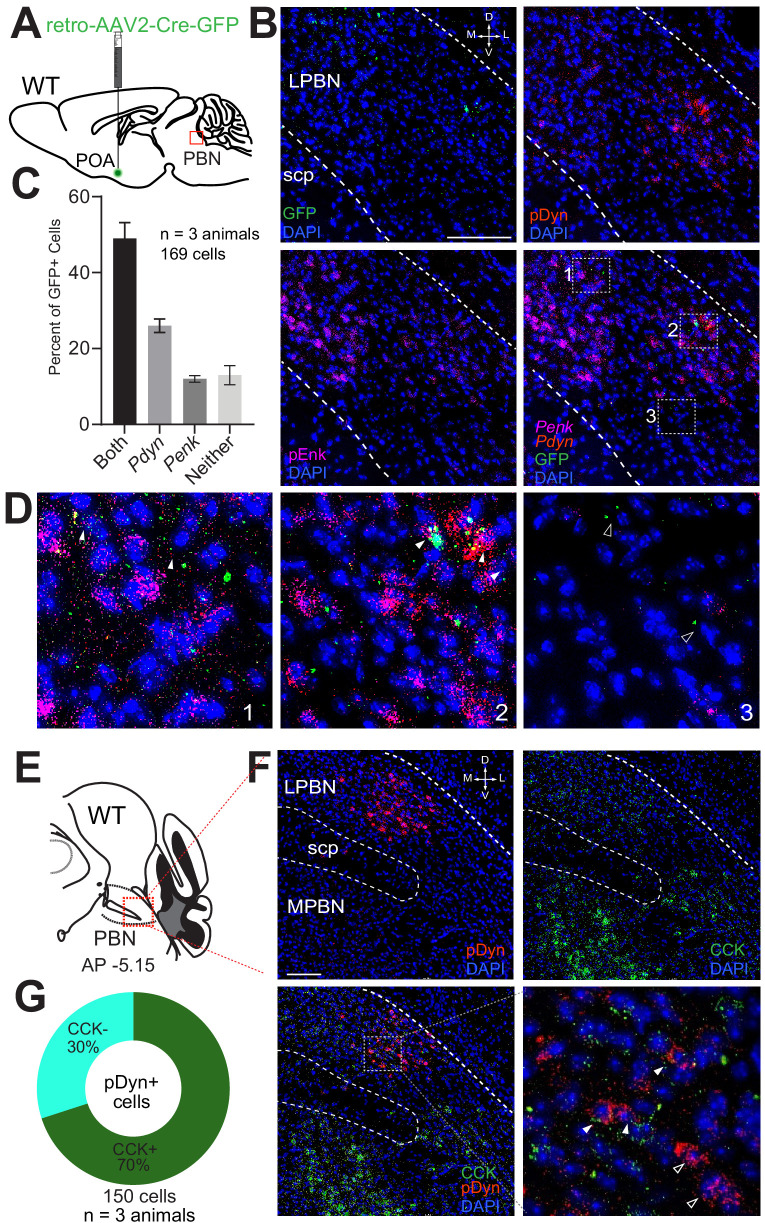
Expression of Pdyn and/or Penk in parabrachial nucleus (PBN)→POA projecting neurons and partially overlapping expression of Cck and Pdyn in LPBN.We examined the expression of Pdyn and Penk in PBN→POA neurons. (A) PBN→POA neurons were marked by injection of retrograde AAV constructs expressing GFP into the POA. (B and C) We performed FISH to label neurons for GFP, Penk, and Pdyn. We found that of cells in LPBN labeled by retroAAV-eGFP 49 ± 4% (mean ± SEM) were also labeled by Penk and Pdyn. (D) The detailed view for the three numbered areas in the overlaid image. Closed arrows mark GFP, Penk, and Pdyn labeled neurons and open arrows mark neurons only labeled for GFP. Of the remaining GFP labeled LBPN neurons 26 ± 2% were labeled by either Pdyn or 12 ± 1% (mean ± SEM) by Penk but not both. 13 ± 3% (mean ± SEM) of GFP labeled LPBN neurons were not labeled by either. n = 3 mice, 169 cells (B and C). We also performed FISH in brain sections from WT mice to examine expression of Cck and Pdyn in PBN neurons. (E and F) Pdyn labeled cells were seen in the lateral PBN and (F) Cck labeled cells were seen in both medial and lateral areas with a more intensely labeled population in the MPBN. Pdyn cells were found to both co-label with Cck (closed arrows) and not co-label with Cck (open arrows). (G) Quantification of randomly selected Pdyn labeled cells in serial PBN sections from three animals demonstrated a mean ± SEM co-labeling with Cck in 70 ± 0.7% of Pdyn cells (n = 3 mice, 150 cells). Scale bars 100 µM.